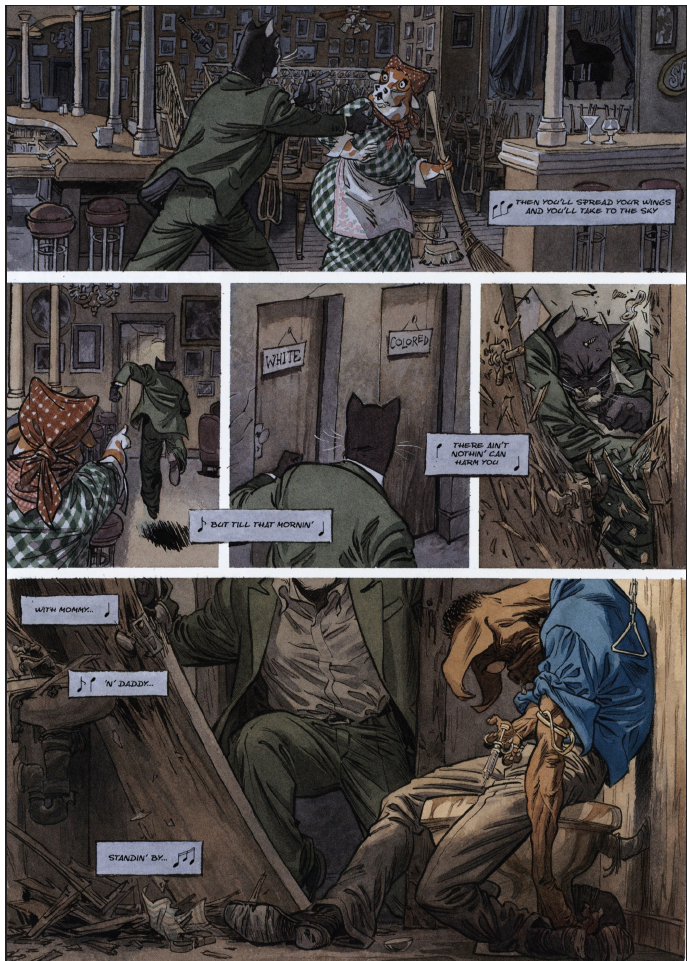
Figure 4: Juan Díaz Canales and Juanjo Guarnido, Blacksad: A Silent Hell , 2012, Dark Horse Books, p.